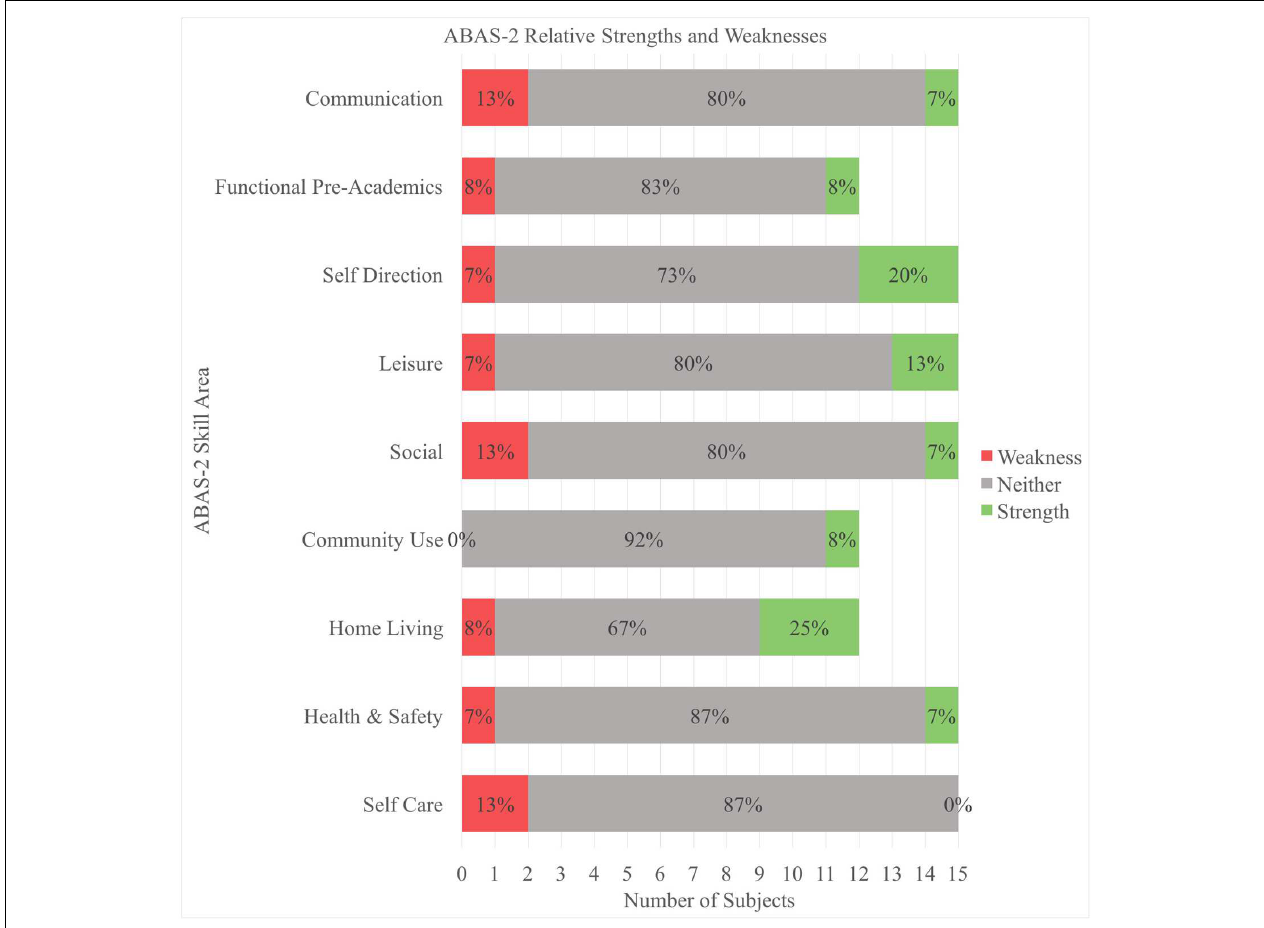
FIGURE 1 | Graph displaying percentages of participants that displayed a relative strength, weakness, or neither across skill sets. Home Living, Functional Pre-Academics, and Community Use skill sets do not include participants under the age of 1